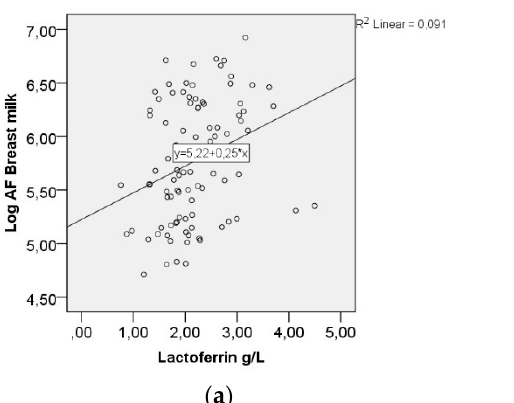
Figure 6. ( a ) Correlation between the AF-levels in breast milk and lactoferrin, Spearman’s rho 0.341, p < 0.01; ( b ) Correlation between the AF-levels in plasma and lactoferrin, Spearman’s rho 0.193, p = 0.06.